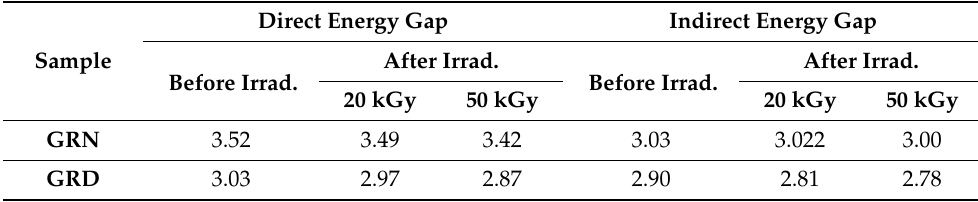
Table 2. Energy Gap Values for GRN and GRD Glasses Before and After Gamma Irradiated. Figure 6. Tauc plot of GRN samples before and after gamma irradiation doses for ( a ) direct and ( b ) indirect energy gap.